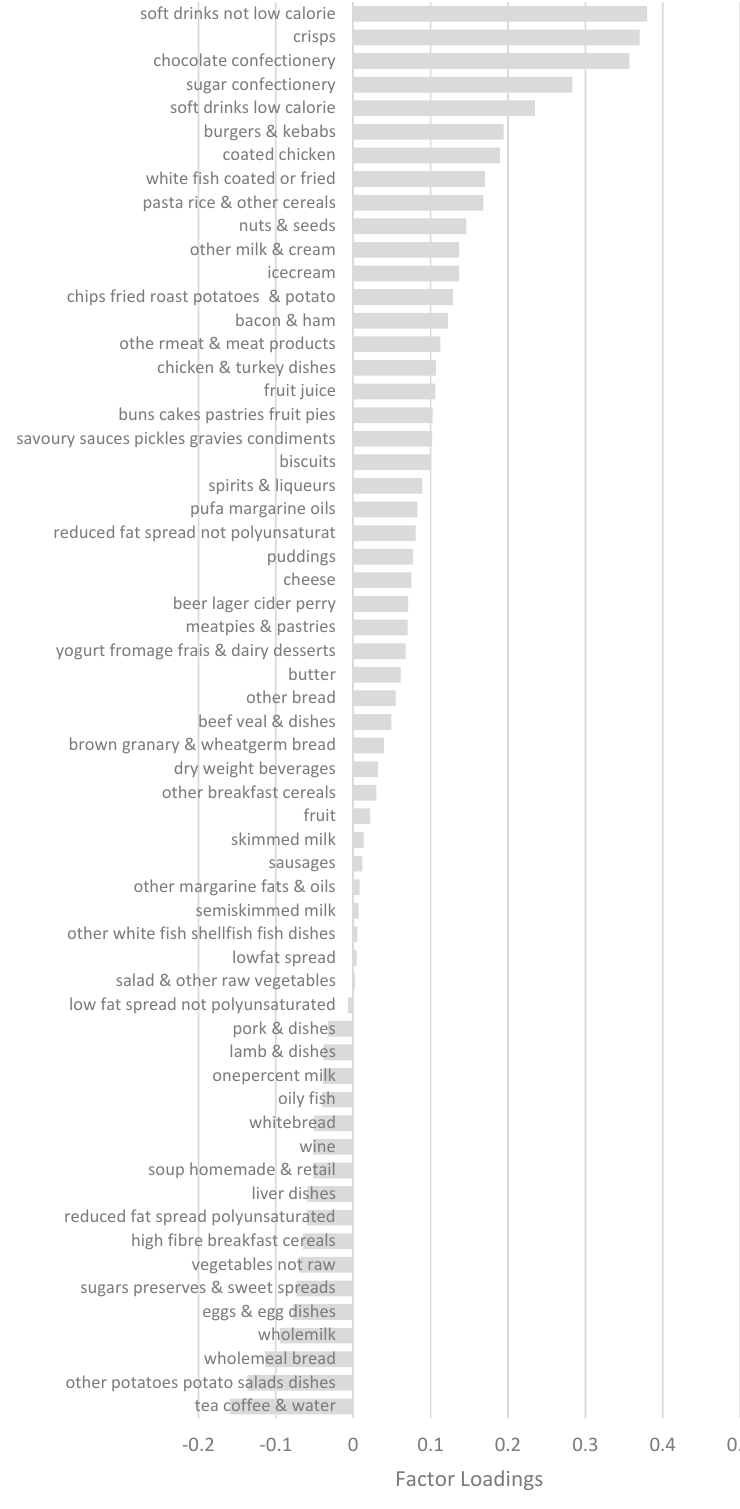
Figure 2. Factor loadings for dietary patterns. Abbreviations: PUFA, Polyunsaturated fatty acids.